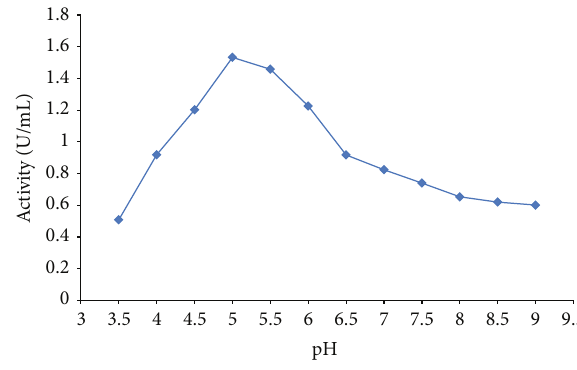
Figure 2: Effect of pH on peroxidase